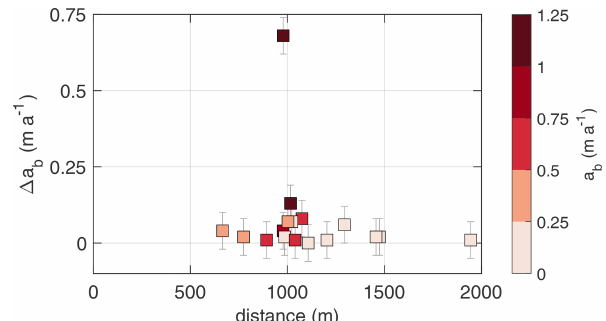
Figure 4. Small-scale variability of basal melt rates. Difference in basal melt rate (cid:49)a b as function of distance between two nearby stations (average distance: 1126 ± 296m). The colour of each dot represents a b of the station with the larger basal melt